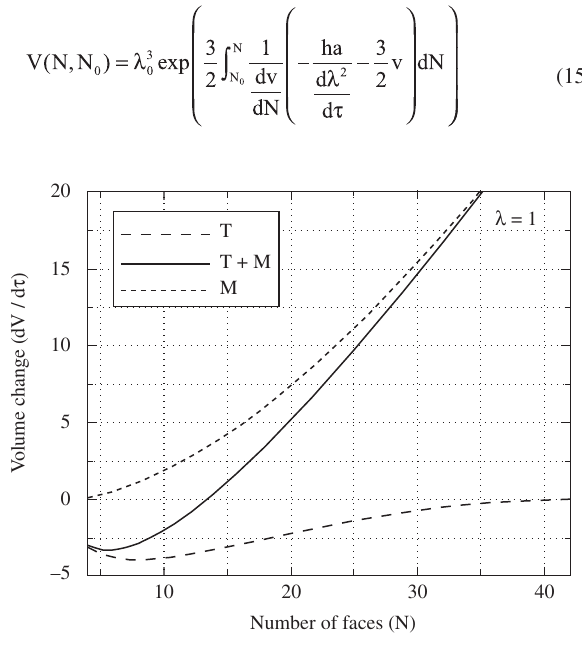
Figure 2. The total grain volume change ‘T + M - curve’ decreases for grains = 13.397 faces, and with positive curvature, i.e., grains with less than N C increases for grains with a greater number of faces. The metric contribution, ‘M - curve’ is always positive. It increases with an increase in the number of grain faces. Grains with a large number of faces tend to have a large metric contribution whereas grains with a small number of faces tend to have a small metric contribution. The topological contribution, ‘T - curve’ behaves in the opposite way, it is always negative and it decreases with an increase in the number of grain faces.